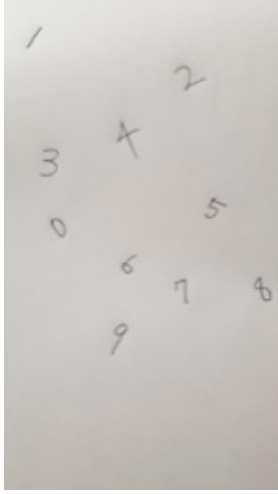
Figure 2. Example of a target document.